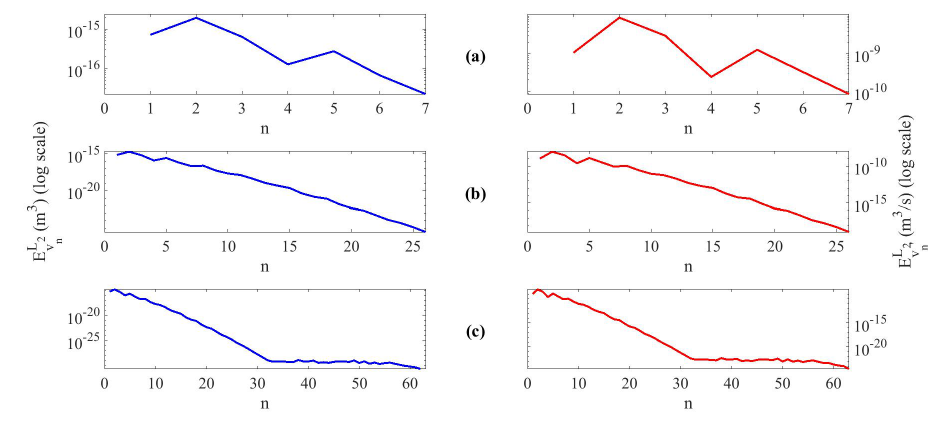
Figure 8. Case 1. f = f b , high finite amplitude with nonlinear terms. L 2 -norm error in logarithmic scale at each iteration n of the calculation; ( left ) v n , ( right ) v (cid:48) n . ( a ) (cid:101) = v b 0 × 10 − 1 , ( b ) (cid:101) = v b 0 × 10 − 10 , ( c ) (cid:101) = v b 0 × 10 − 20